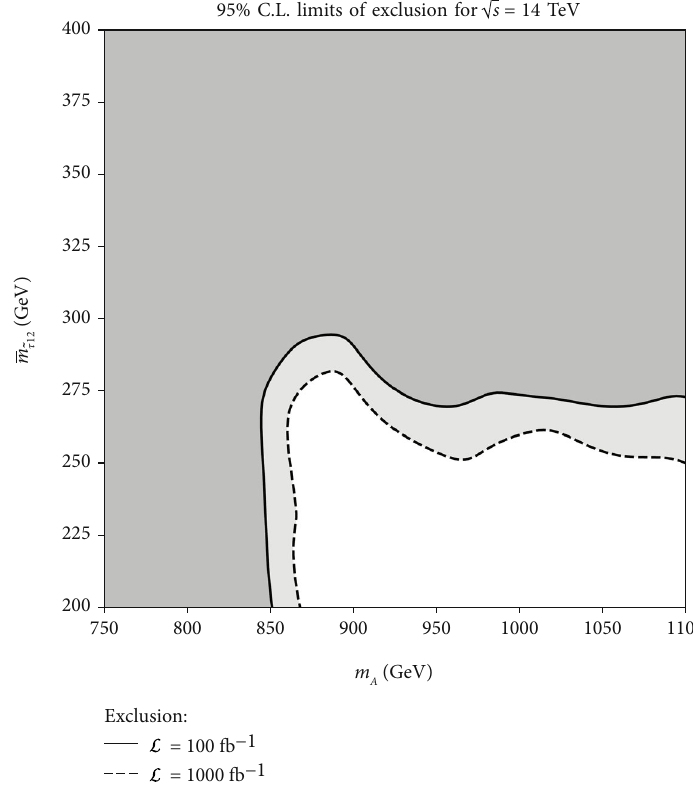
ffiffi p == 14 TeV and total s